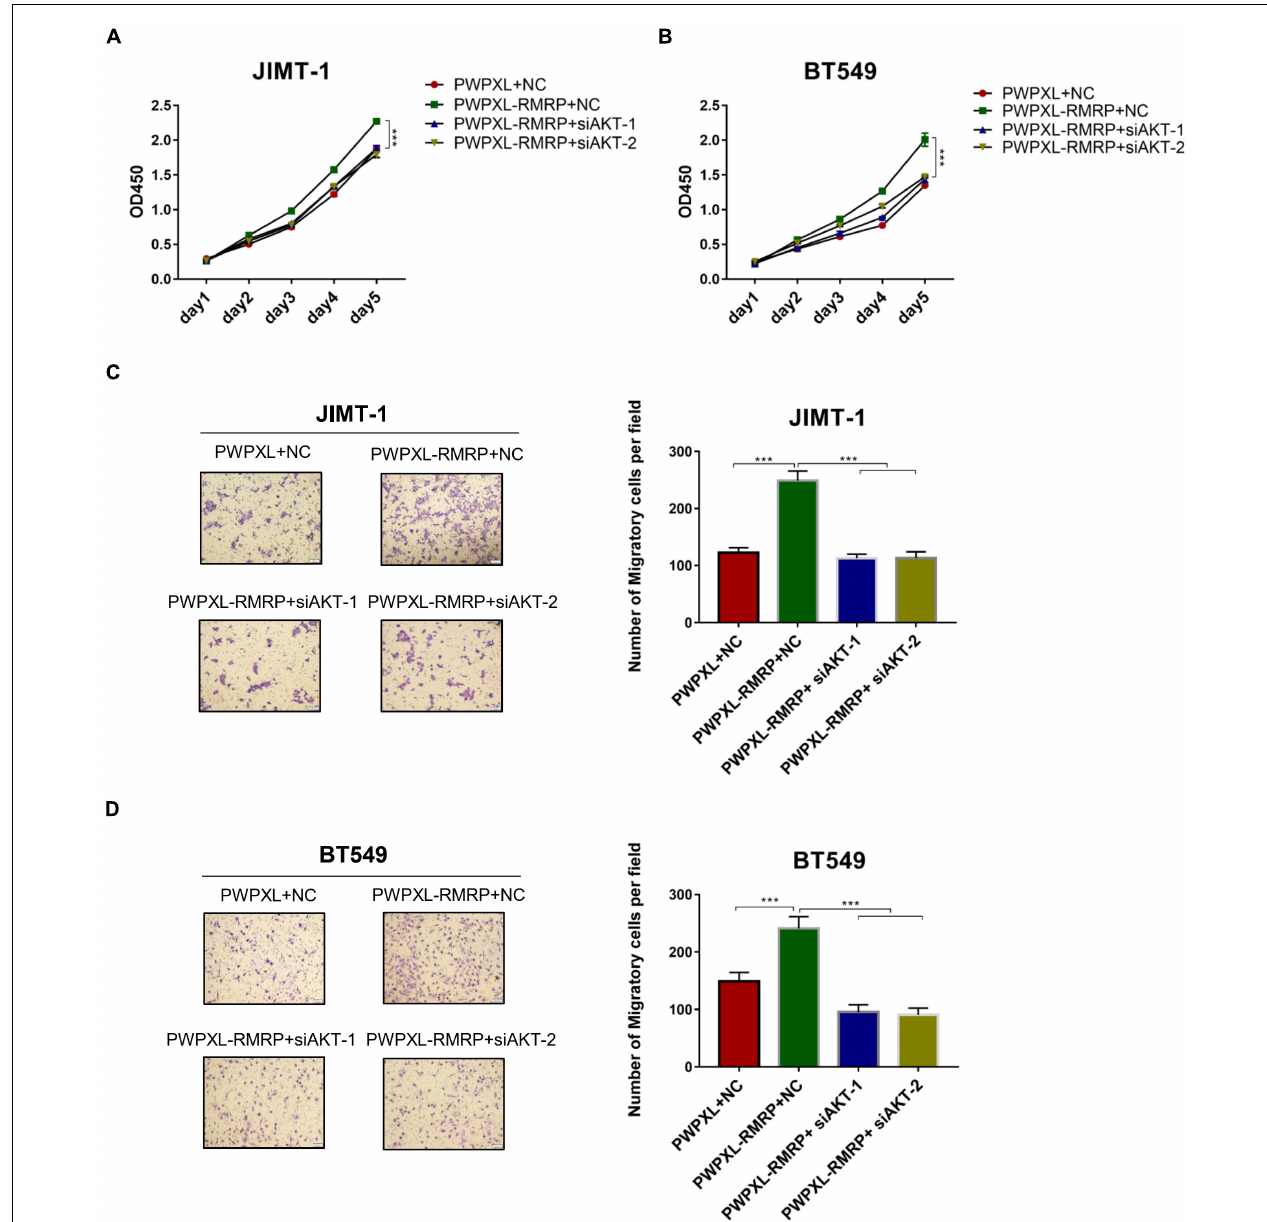
FIGURE 6 | Ectopic RMRP promotes breast cancer cell growth and migration dependently of AKT. (A) Knockdown of AKT restores RMRP-induced JIMT-1 cell proliferation determined by the CCK-8 assay. (B) Knockdown of AKT restores RMRP-induced BT549 cell proliferation determined by the CCK-8 assay. (C) Knockdown of AKT abolishes RMRP-induced JIMT-1 cell migration determined by the Transwell assay. (D) Knockdown of AKT abolishes RMRP-induced BT549 cell migration determined by the Transwell assay. *** p < 0.001.